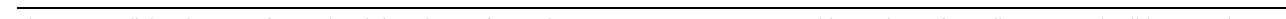
Fig. 2 Intracellular cleavage of sE-cad and the release of sE-cad-positive exosomes. a Western blot analysis of E-cadherin in total cell lysate and conditioned medium (CM) of Caov-3 and OV-90. b Western blot analysis of the subcellular localization of E-cadherin in Caov-3 and OV-90 by sucrose density gradient fractionation. Ves vesicles, TGN trans-Golgi network, ER endoplasmic reticulum, PM plasma membrane. Upper: Representative western blot images. Lower: Densitometry of FL-E-cad. c Western blot analysis of the protein composition of exosomes isolated from Caov-3 and OV-90. d Sucrose density gradient fractionation of exosomes isolated from Caov-3 and OV-90. Upper: Densities (g cm − 3 ) of each sucrose fraction as determined by refractometry. Lower: Representative images of western blot. e Immunoelectron microscopic view of the sE-cad localization on the exosomal surface of Caov-3 and OV-90 cells at a magni fi cation of 52,000×. Bar, 100 nm. Localization of CD63 as a positive control was visualized. No staining was found on exosomes incubated with an isotype-matched control IgG. f The number of particles per μ g exosomes and median diameter were determined by nanoparticle tracking analysis. n = 3 per group, all experiments were repeated three times. Error bar indicates SD of the